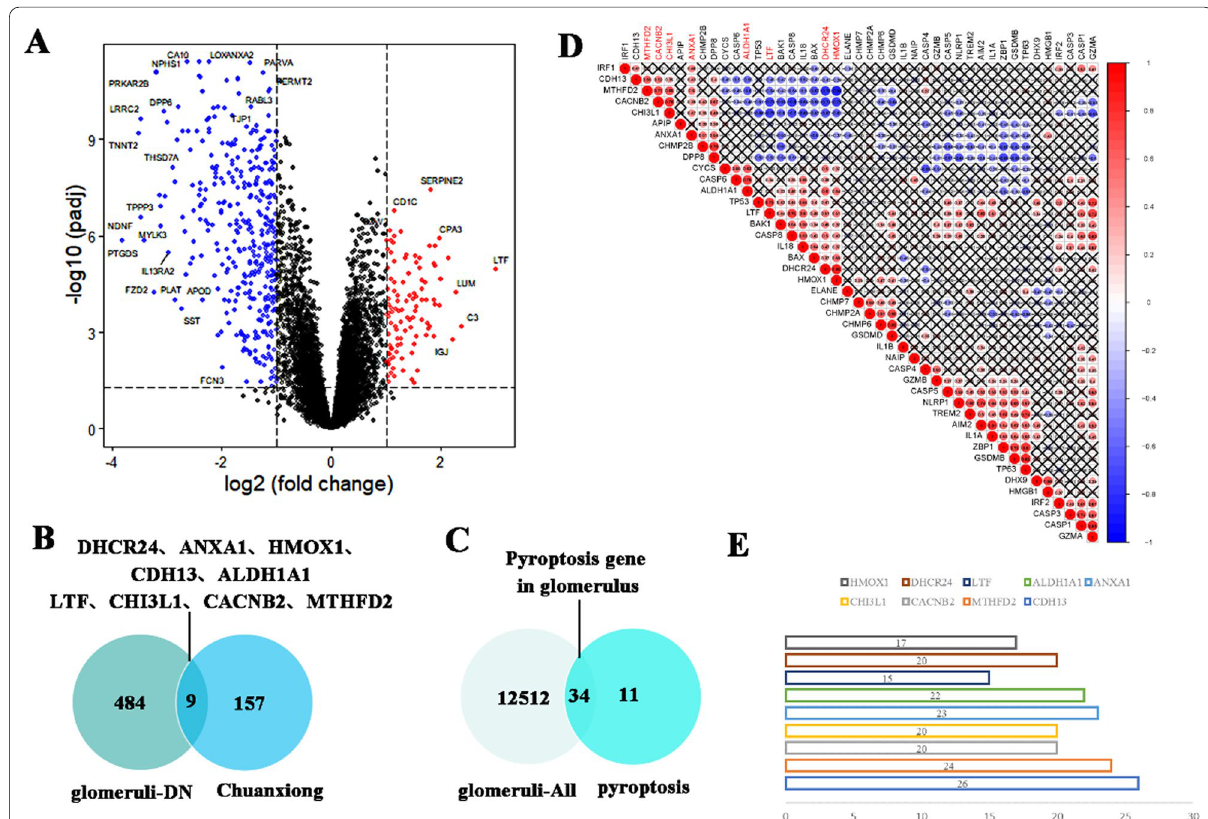
Fig. 1 A Diff genes of DN by using the limma package (LogFC interaction for DN; E the 9 drug target genes were sequenced according to the number of correlation degree with pyroptosis genes * P < 0.05; ** P < 0.01; *** P <